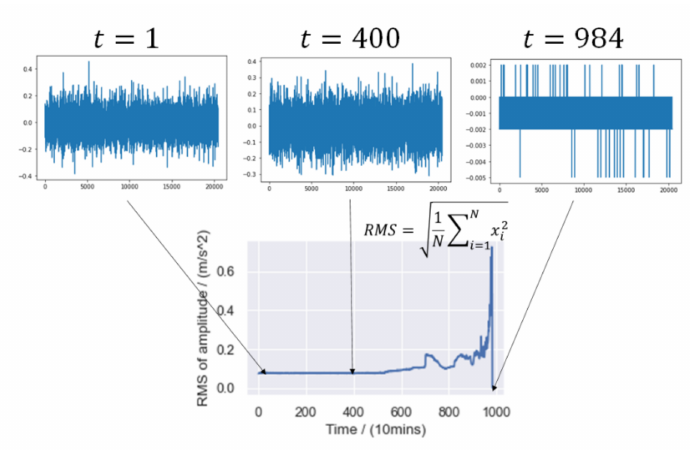
Figure 8. Pre-processing of vibration data.